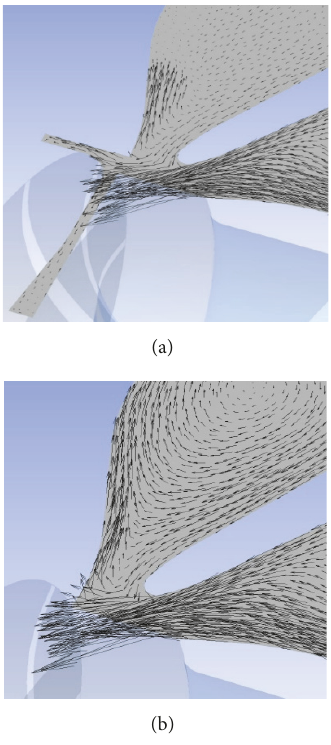
Figure 18: Velocity vectors in a volute cross section for partial shroud admission (a) with the backside cavity and (b) without it.